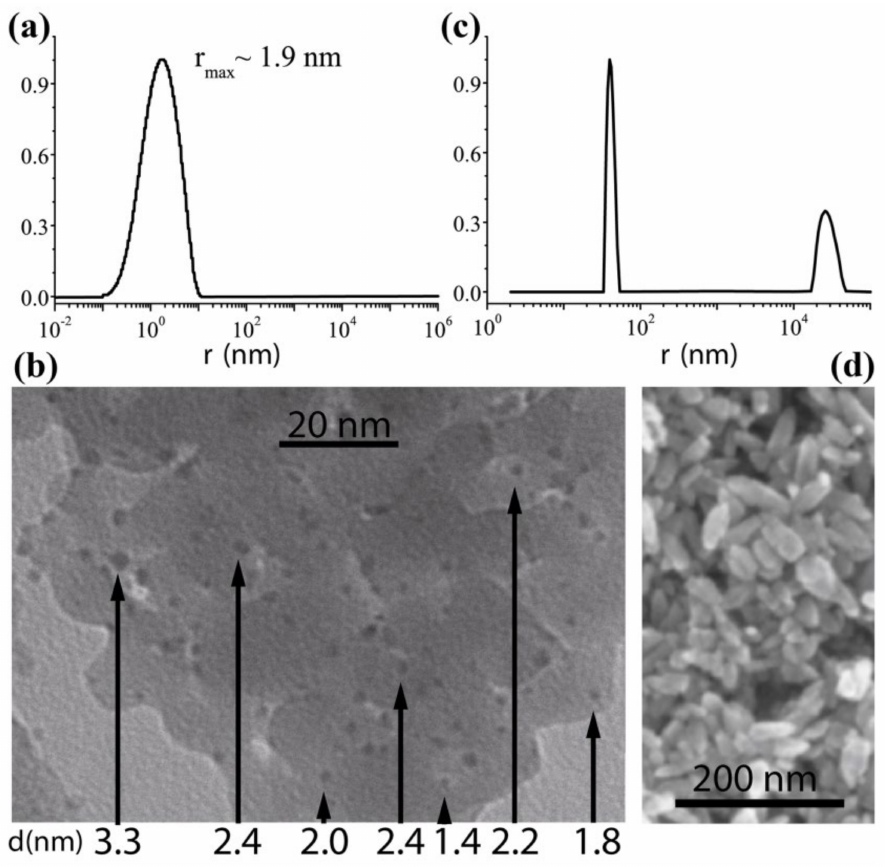
Figure 1. The results of Ag ( a , b ) and ZnO ( c , d ) nanoparticles characterization: ( a , c ) characteristic size measurements using the correlation spectroscopy method processed with the use of DynaLS software; ( b , d ) scanning transmission electron microscope patterns along with the diameter values extracted for several